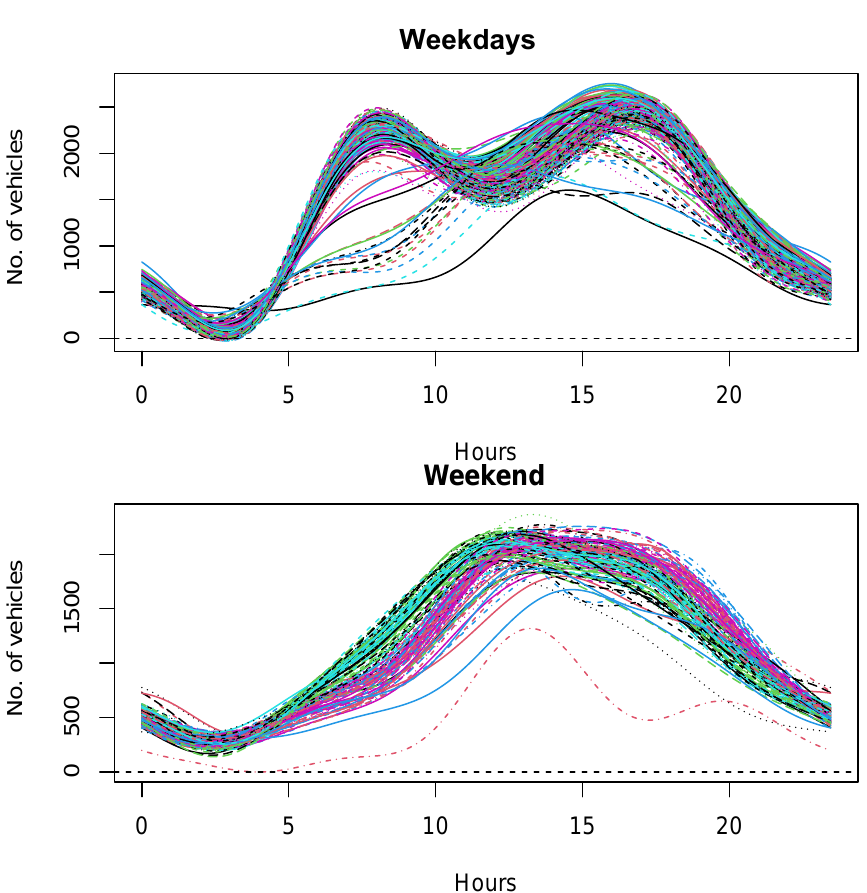
Figure 3. Daily traffic flow curves for ( top ) weekdays ( bottom ) weekends, for the period 01/01/2016–